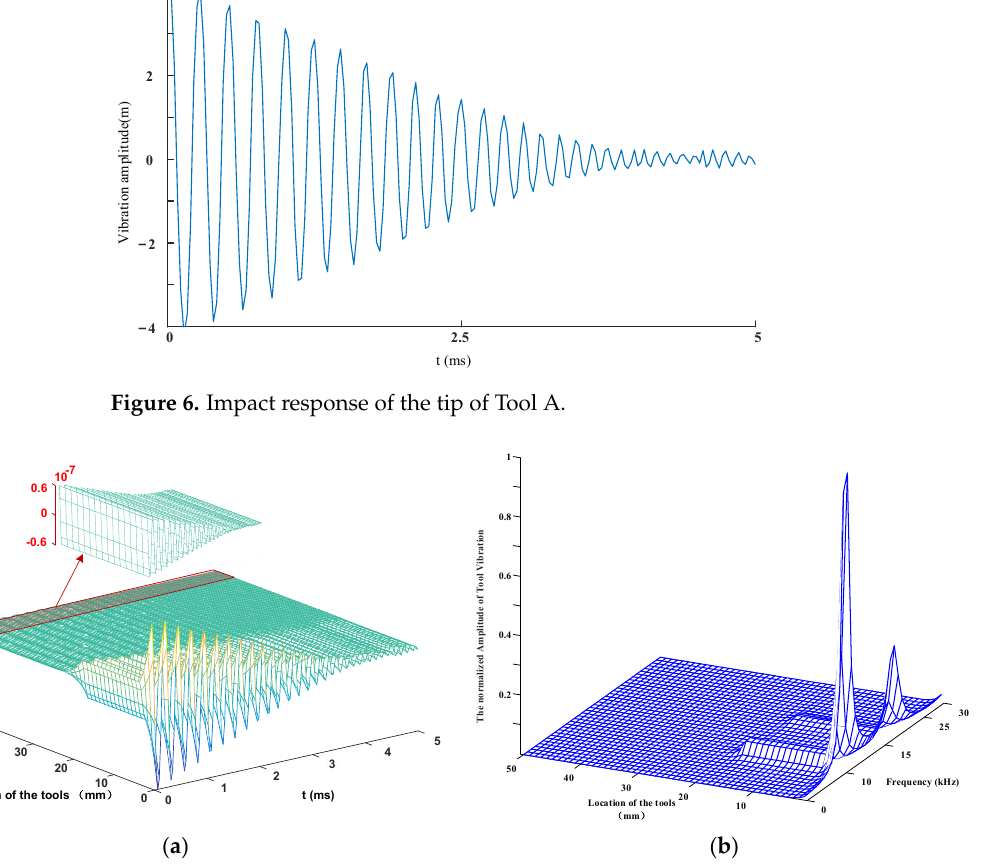
Figure 8. Impact response of the tip of Tool B. Location of the tools （ mm ） ( b ) Figure 9. Vibration Propagation of Tool B. ( a ) Time domain transfer characteristic and ( b ) frequency domain transfer characteristics. 4. Experiment Results and Discussions Figure 10 shows the micro-milling tool vibration measurement experimental system. It consists of seven main parts: a desktop milling machine (with micro-milling tool), a voltage-stabilized source, four light sources, an optical-electric conversion module, a DAQ card, and the optical fiber sensor array. The speed range of the desktop milling machines is from 0 to 10,000 RPM with the power of 480 W. It is made by the MENCHAO Company.